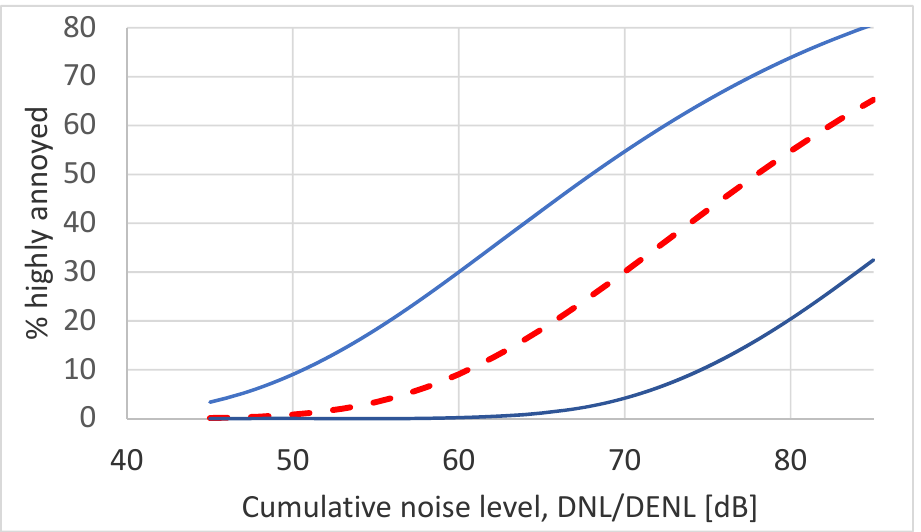
line (black) is the ERF developed by Miedema and Vos. Standard second order polynomial regression yields the dash–dot ERF (yellow) while CTL analysis yields the dashed ERF (red).